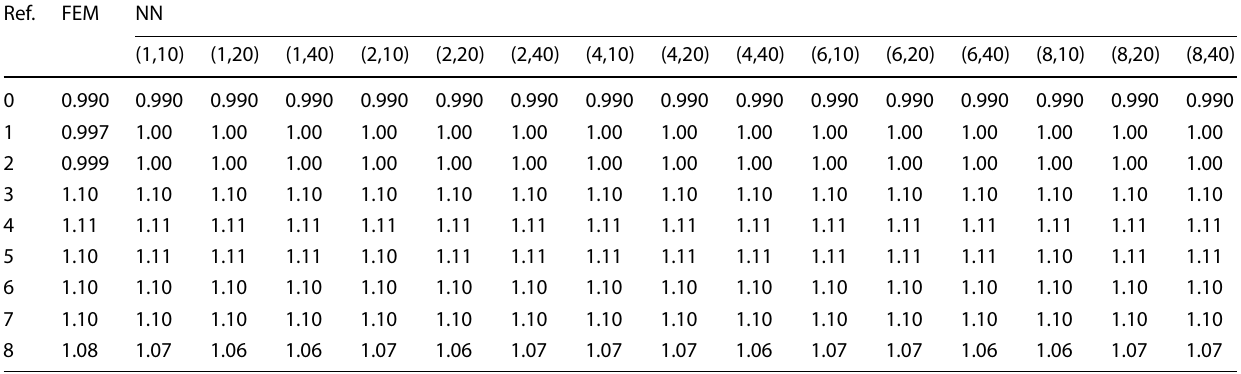
have a standard deviation of 0.01. The neural networks are being denoted by tuples where the first number corresponds to the num- ber of hidden layers and the second number represents the num- ber of neurons therein